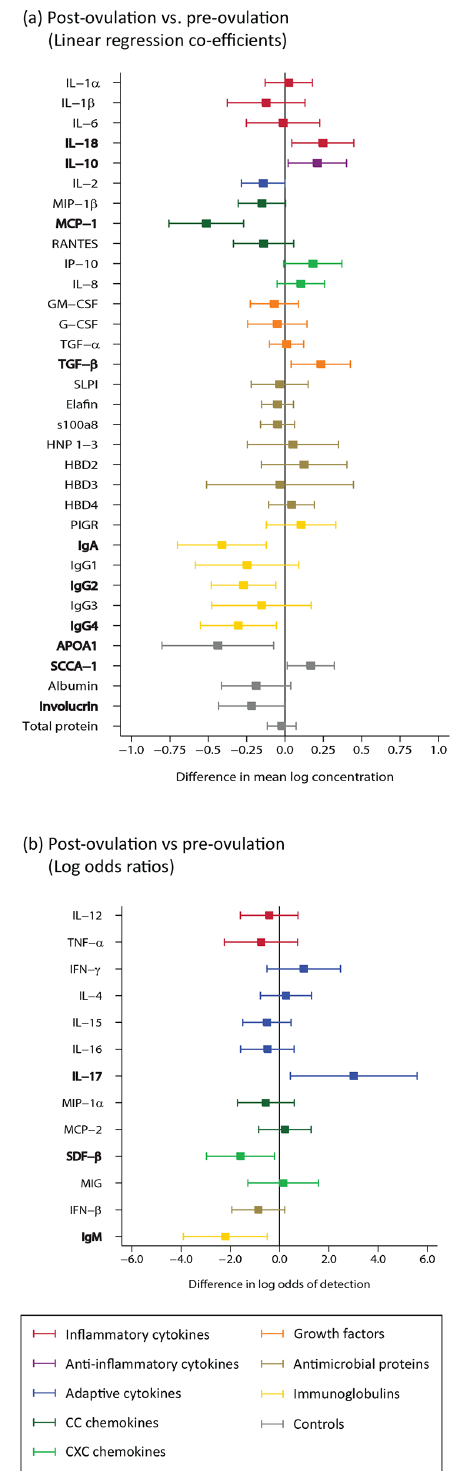
Fig 2. Menstrual cycle phase (n = 102). A comparison of analyte concentration between samples from visits occurring post-ovulation to pre-ovulation (reference). Menstrual cycle stage was assessed by measurement of urine pregnanediol 3-glucuronide. Bolded analytes represent associations with a p-value (cid:1) 0.05. (A) Analytes with (cid:3) 85% detection using linear regression showing coefficients (boxes) and confidence intervals (lines) (B) Analytes with < 85% detection using logistic regression showing odds ratios (boxes) and confidence intervals